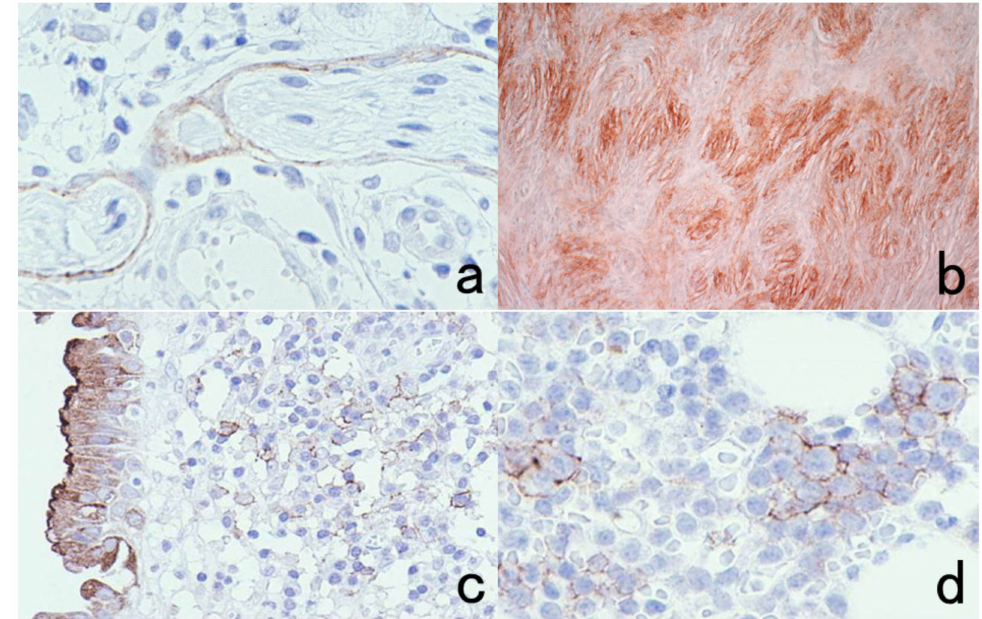
Figure 55. Epithelial membrane antigen (EMA) expression in normal ( a , c ) and neoplastic ( b , d ) per- ineurial cells (top panels: ( a , b )) and plasma cells (bottom panels: ( c , d )). It should be noted that EMA is positive in certain non-epithelial cells and their tumors (perineurioma and multiple myeloma). Perineurial cells surrounding the peripheral nerve sheath represent peripheral meningothelial cells. Chronic cervicitis containing numerous plasma cells is covered with EMA-positive columnar epithe- lial